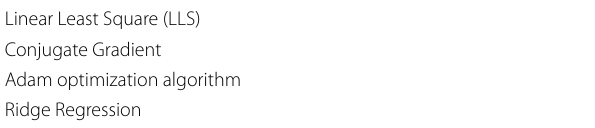
Table 1 Applied linear regression